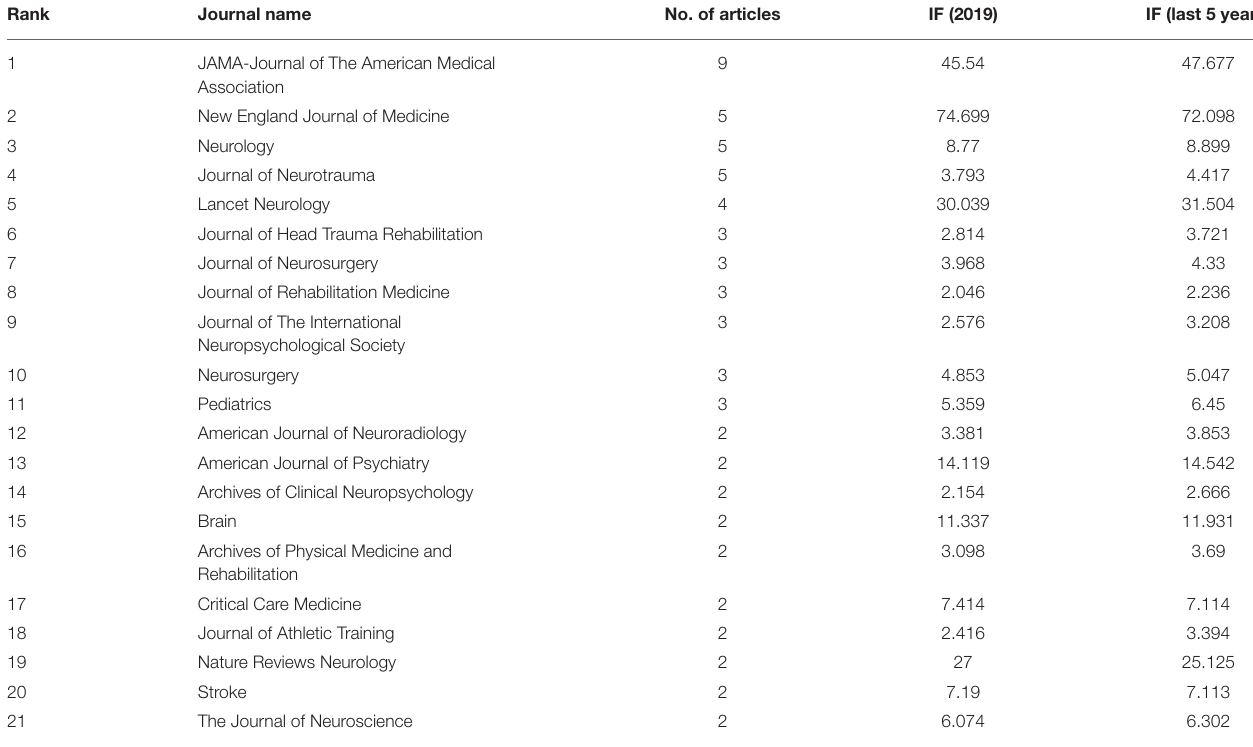
TABLE 3 | Journals with more than 2 top-100 cited